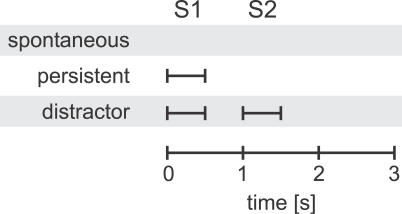
The Simulation ProtocolsStimuli to either S1 or S2 are applied at different times depending on the type of simulations. The spontaneous simulations include no input. The persistent simulations assess how stably a stimulus is retained by the network. The distractor simulations add a distractor stimulus to further address the stability of the network activity.